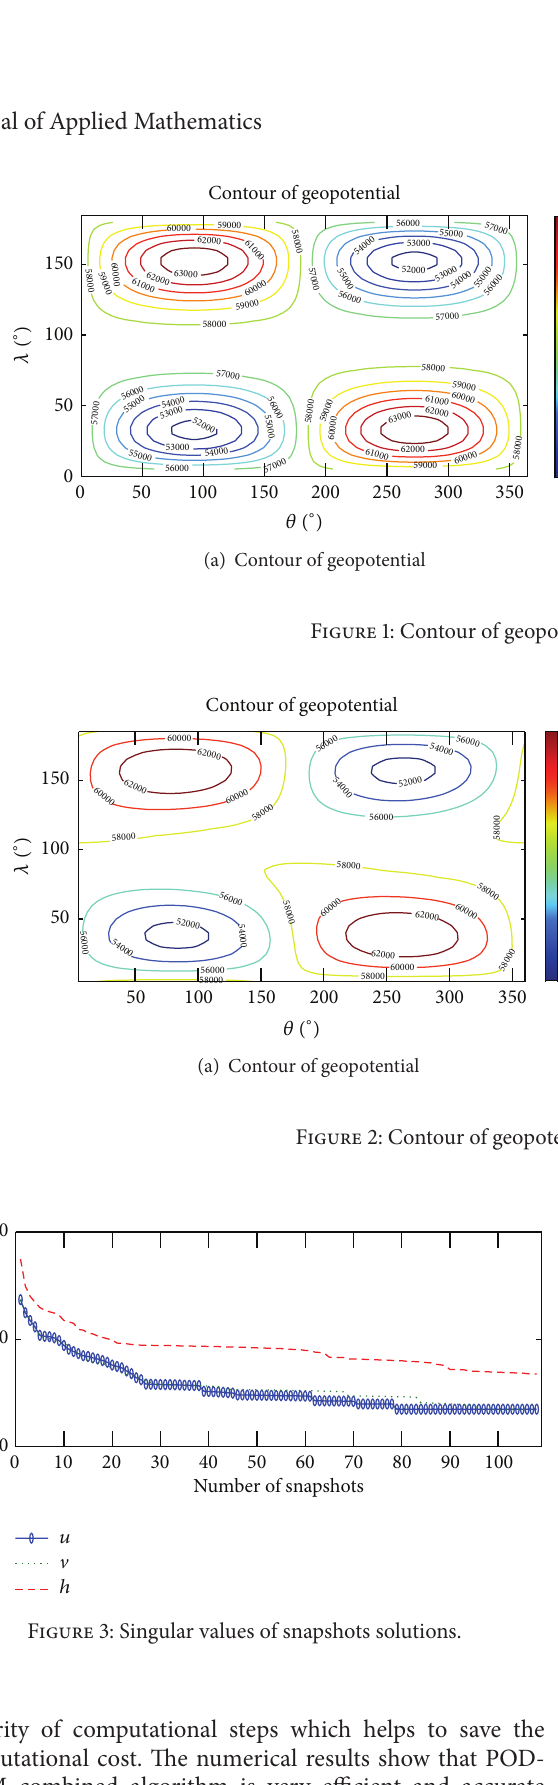
in doing model order reduction on spherical shallow